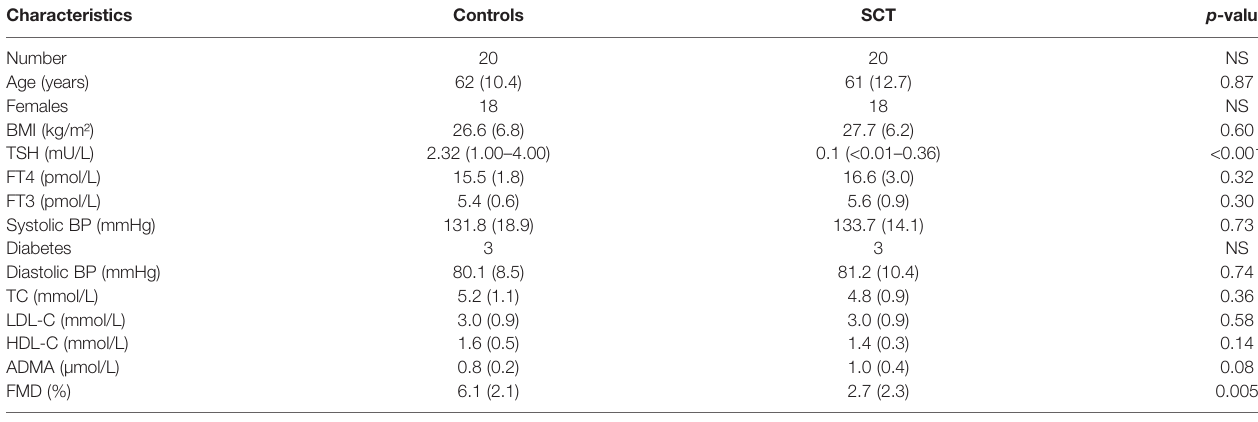
TABLE 3 | Summary of differences in parameters in two groups.